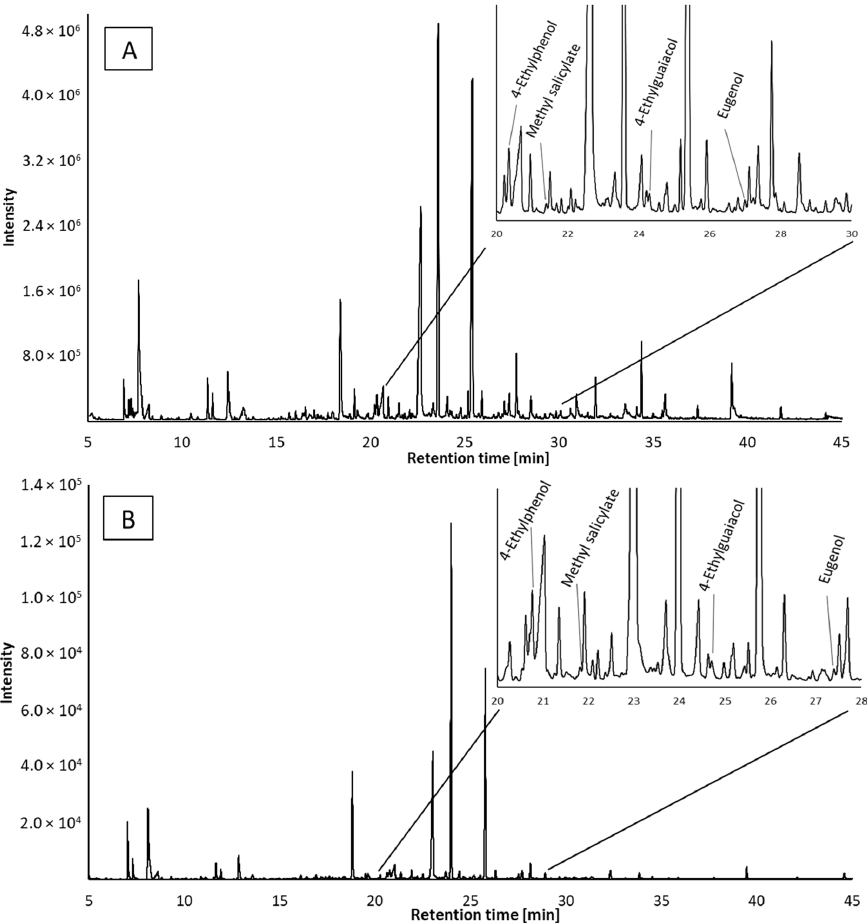
Figure 2. Gas chromatographic analysis of volatile organic compounds in sample 14 (( A )—MS detection; ( B )—FID detection).